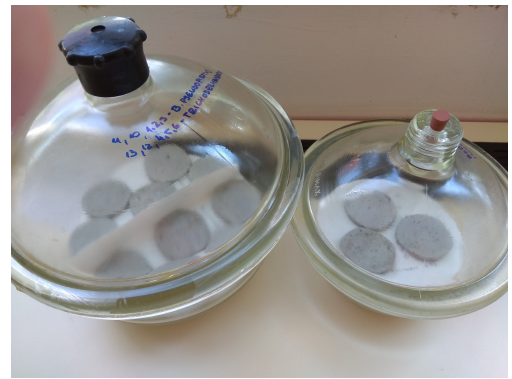
Figure 6. Concrete specimens in desiccators.